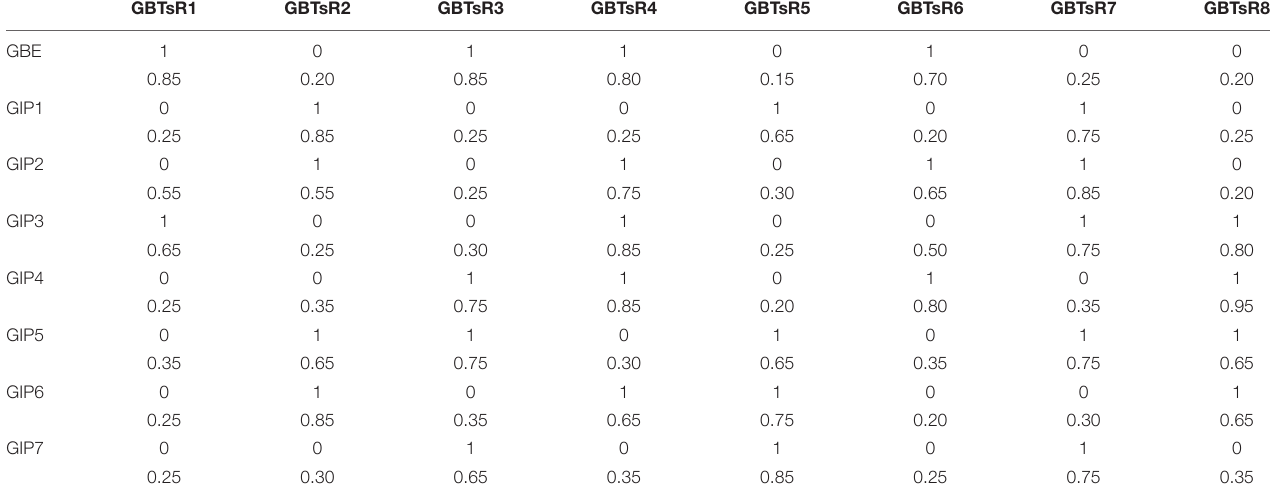
TABLE 4 | The status of DGI resources of